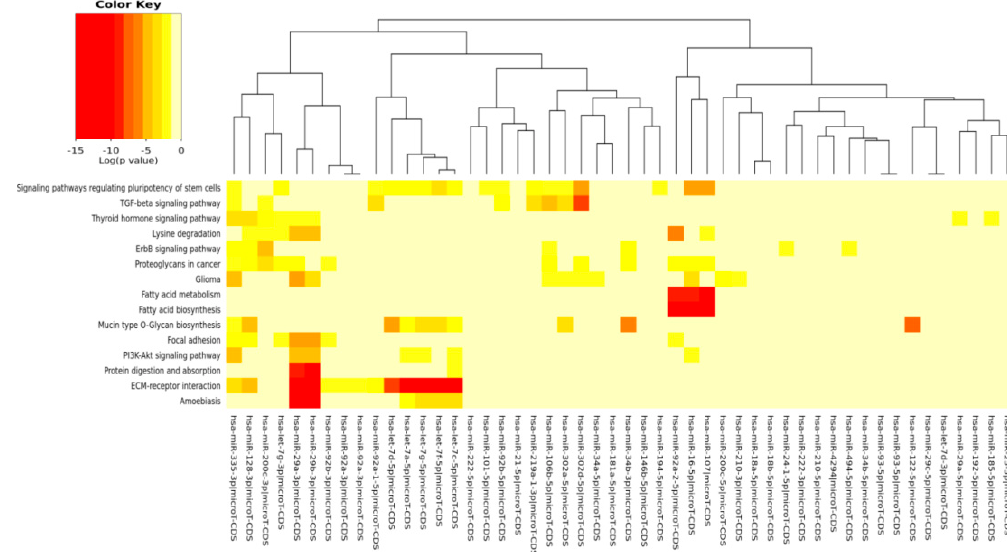
Figure 3. MicroRNAs involved in DDR and modulated by EGCG versus the pathways’ heat map. In this plot, heat map calculation is based on absolute p -values. Darker colors represent lower p -values (higher significance). The plot shows miRNAs targeting similar pathway clusters and pathways being targeted by miRNA groups.